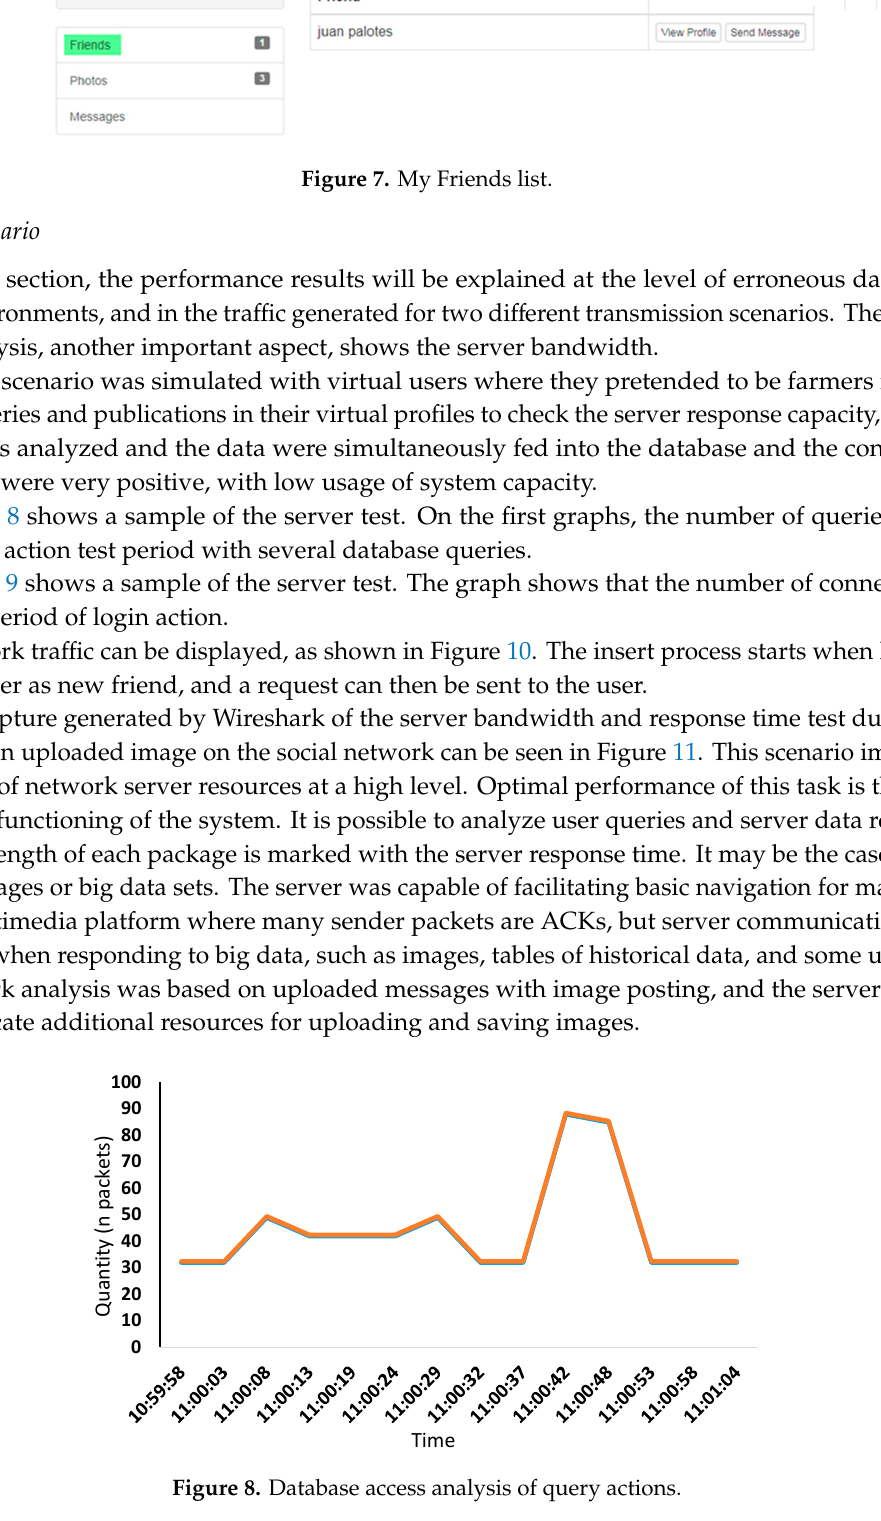
Figure 7. My Friends list.